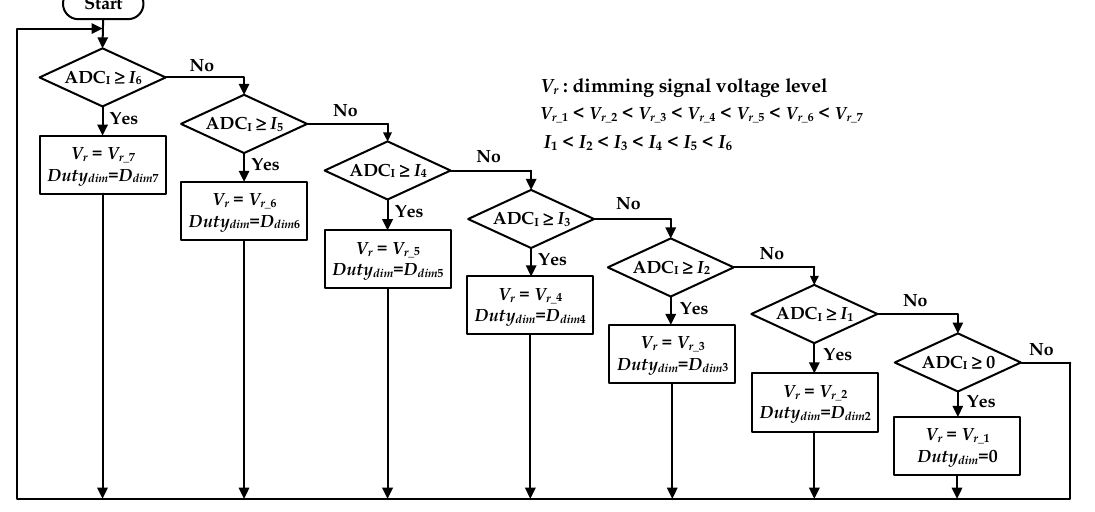
Figure 10. Control process of the dimming with VDSV.